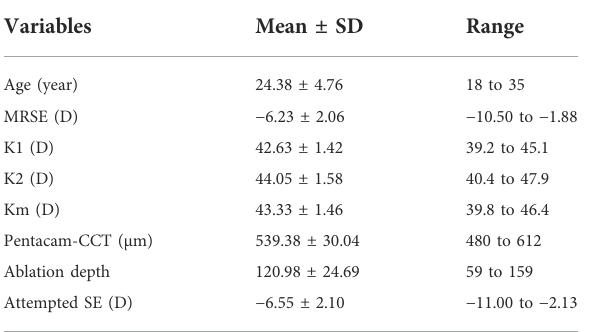
TABLE 1 Demographic and topographic data.